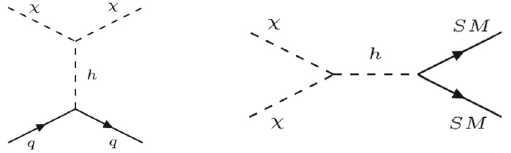
Fig. 2 The contribution to χ -nucleon elastic scattering cross-section (left) and observed relic density of the universe (right) from the dimension-4 operator